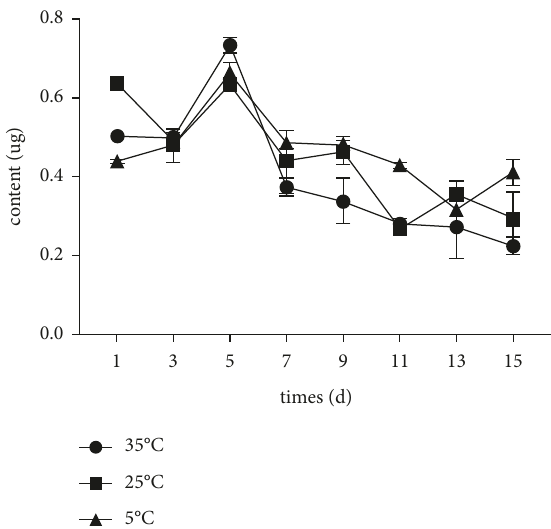
Figure 6: The content change curve at different temperatures of TGG.